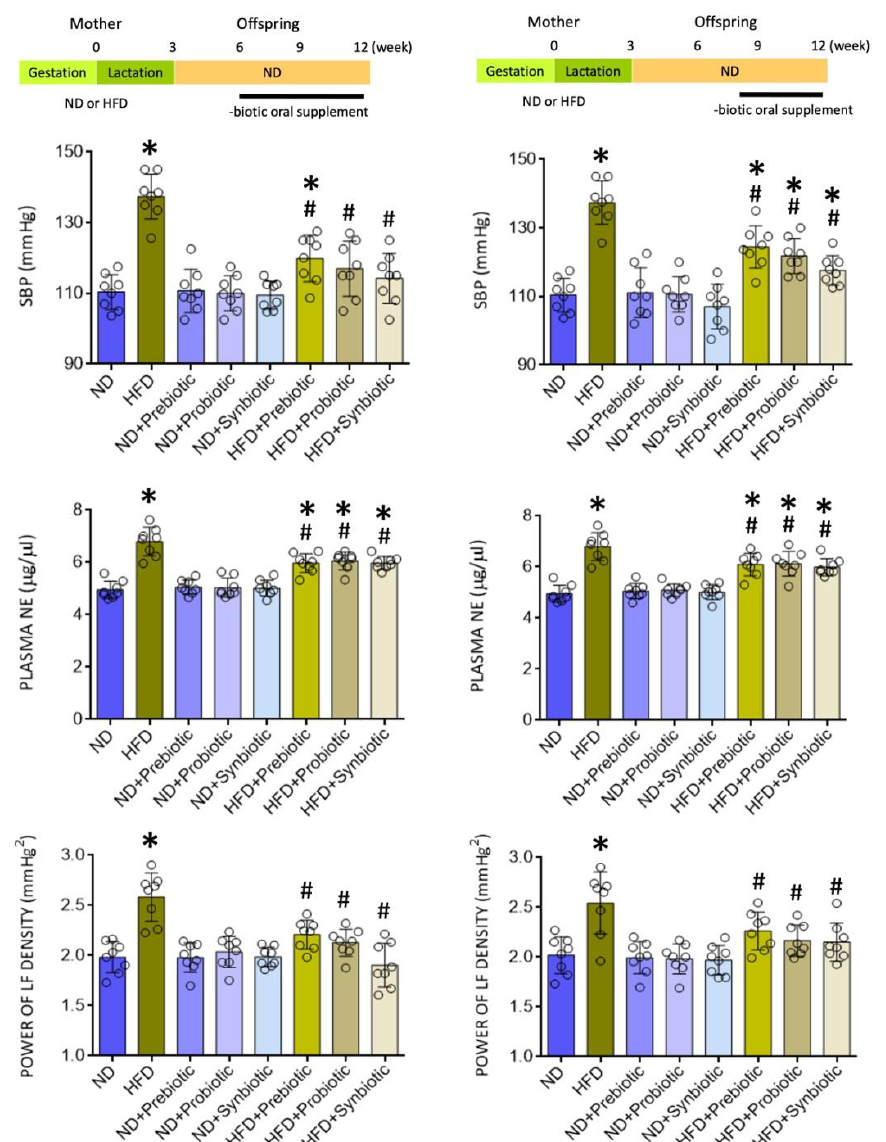
Figure 1. Systolic blood pressure (SBP), plasma norepinephrine (NE) levels, and power density of the low frequency (LF) component of SBP signals in adult offspring from mothers exposed to high fructose diet (HFD) or normal diet (ND) that received oral supplementation of FOS (4 g/kg/day, probiotic), L. gasseri (3 × 10 6 CFU/mL/day, probiotic) or FOS+ L. gasseri (synbiotic) initiated at the age of 6 ( left panels ) or 8 weeks (right panels ). Also presented are schematic diagrams of the experimental design. Data are presented as mean ± SD, n = 8 in each group. * p < 0.05 vs. ND group, and # p < 0.05 vs. HFD group in the post hoc Tukey’s multiple-range